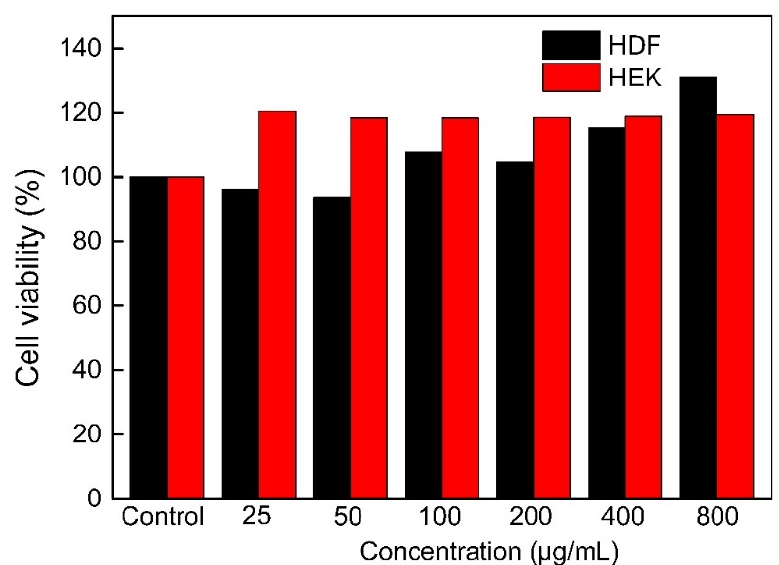
Figure 5. Cell viability of HDF and HEK incubated with IHRPs.